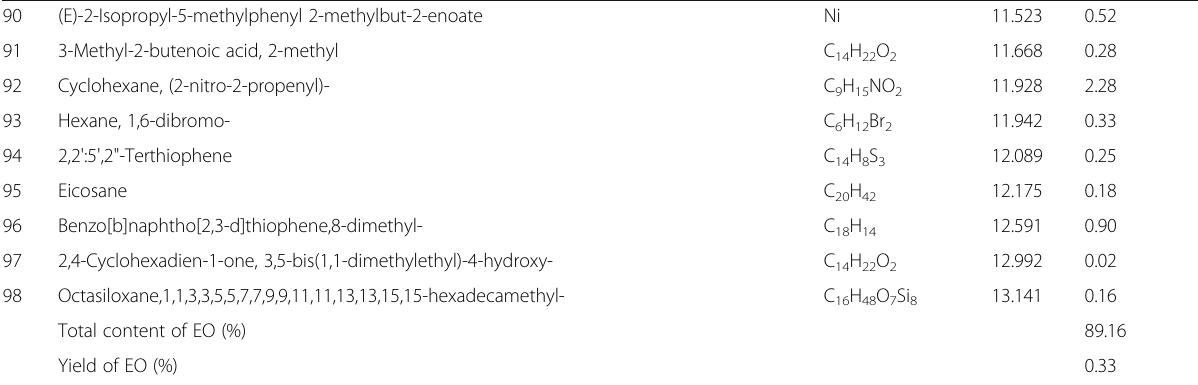
Table 2 Chemical composition of the essential oils of T. minuta flower (Continued)